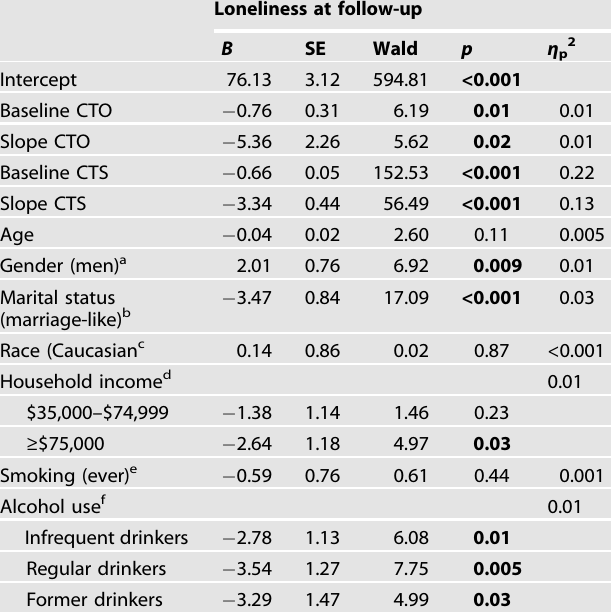
Table 3. Best- fi t linear model of compassion toward others (CTO) and compassion toward self (CTS) with loneliness at